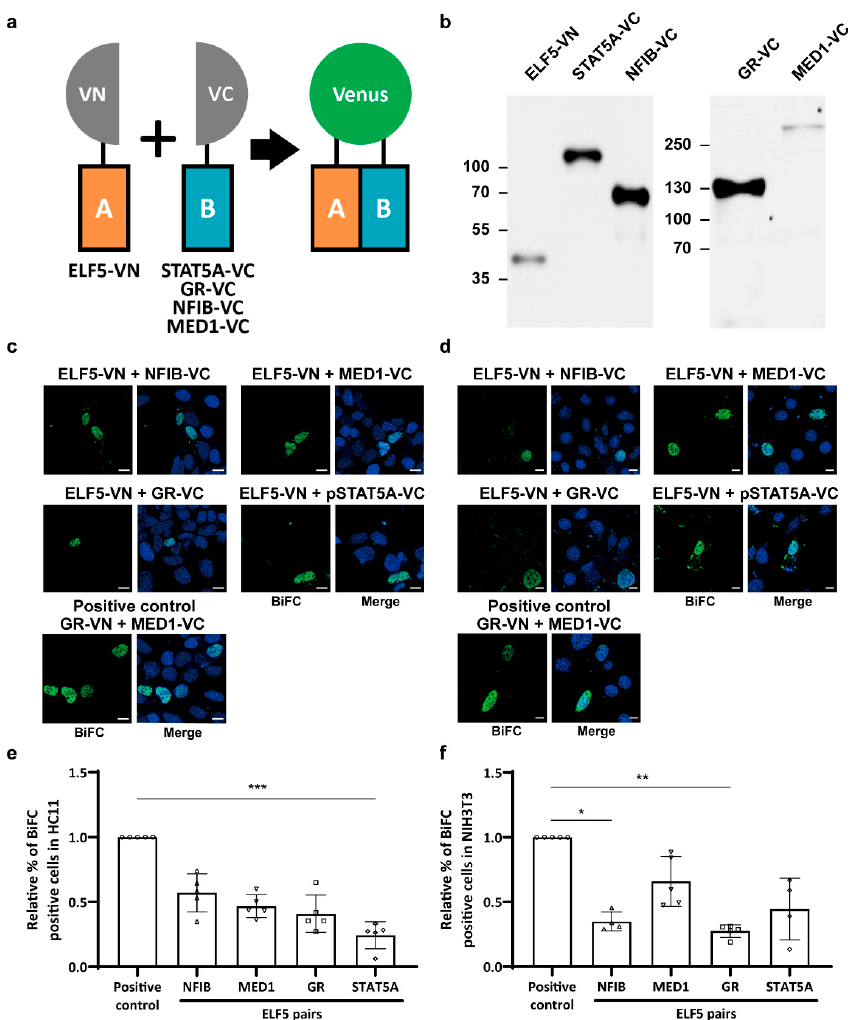
Figure 2. Comparison of in vivo molecular interactions between mammary-enriched transcription factors in mammary epithelial cells and non-mammary cells. ( a ) Schematic illustration of plasmid constructs and the principle of the BiFC assay used to detect protein–protein interactions. ELF5 was tagged with the N-terminal domain of the Venus protein (VN), and STAT5A, GR, NFIB, and MED1 were tagged with the C-terminal domain of the Venus protein (VC). Once VN- and VC-tagged proteins are close enough to interact, the Venus protein becomes reconstituted and emits fluorescence from cells. ( b ) Protein expression of Venus-tagged ELF5, STAT5A, NFIB, GR, and MED1, detected by Western blot analysis. ( c , d ) Fluorescence images obtained from a BiFC assay in ( c ) mammary epithelial HC11 cells (800×) and ( d ) mouse fibroblast NIH3T3 cells (600×). BiFC signals are shown in green, and DAPI-stained cell nuclei are shown in blue. The GR-VN and MED1-VC pair was used as a positive control. Representative images from five independent experiments are shown. Scale bars, 10 μ M. ( e , f ) Relative percentages of BiFC-positive ( e ) HC11 cells and ( f ) NIH3T3 cells. The number of BiFC-positive cells was normalized to that of DAPI-stained cells in three different fields per slide from five independent experiments (* p < 0.05; ** p < 0.01; *** p < 0.001). A circle, a positive control; a triangle, ELF5-NFIB; an inverted triangle, ELF5-MED1; a square, ELF5-GR; a diamond, ELF5-